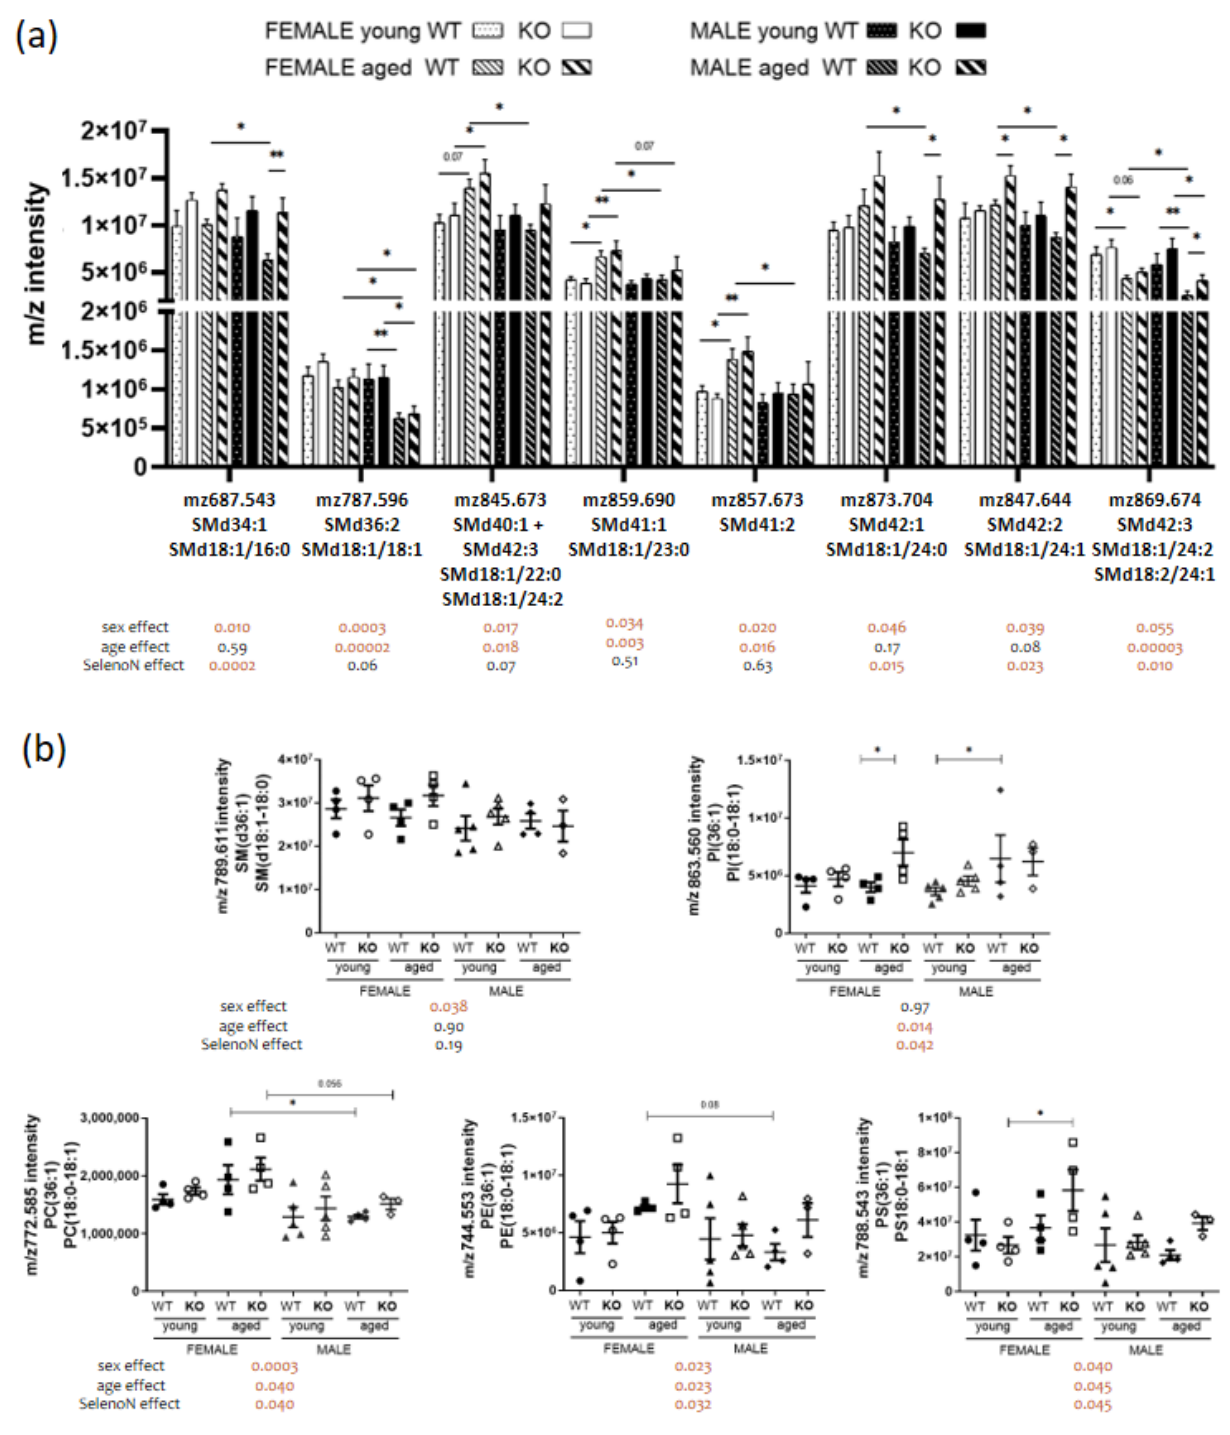
Figure 5. Sphingomyelin and PL (36:1) remodeling in a sex, age and/or SelenoN KO context. ( a ) Analysis of m / z intensity of SM species (mean ± SEM; n = 4 for each group, except young male WT and KO with n = 5 and aged male KO with n = 3). ( b ) Analysis of m / z intensity of PL (36:1) species. In the graph, p -value are from Tukey’s post hoc tests between pairwise groups. Under the graph, p -values for sex, age and SelenoN effect are defined in Table 2. * p < 0.05 and ** p < 0.01.